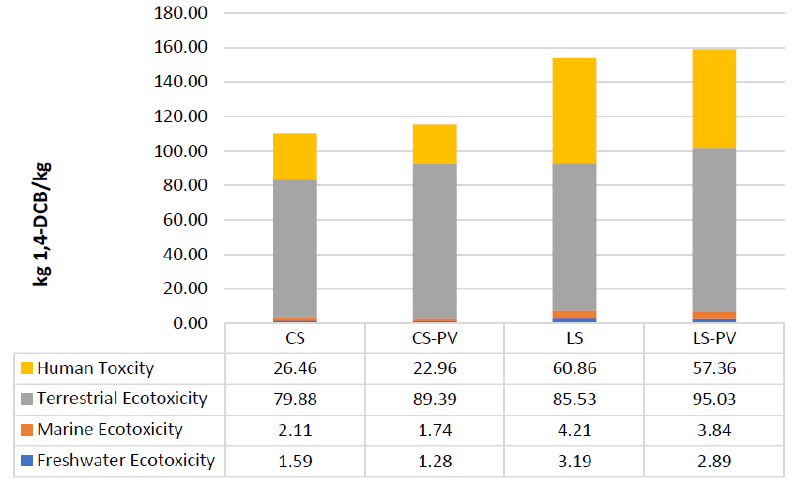
Figure 4. Ecotoxicity indicator results per kg of fresh weight produced by the building-integrated IVF technology for Circular Supply (CS) and Linear Supply (LS) in relationship to each other. Presented in Global Warming (CO 2 e), Freshwater Ecotoxicity, Marine Ecotoxicity, Terrestrial Ecotoxicity and Human Toxicity (kg 1,4-DCB/kg) (Table S2 and Figure S1).